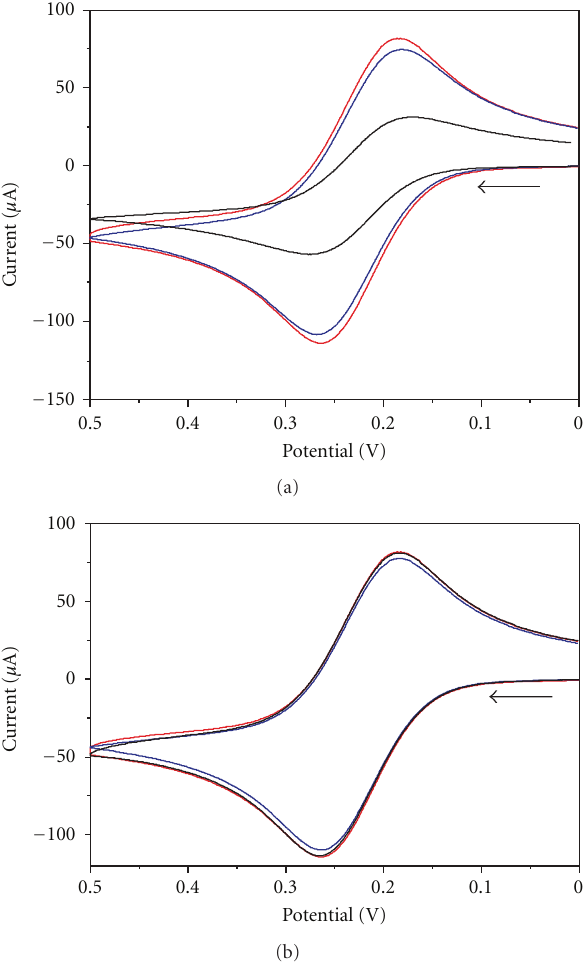
Figure 7: CVs of ferrocene methanol (1mM) in 0.1M KCl at 0.1V/s. (a) Red: bare gold, blue: silica film/sphere-coated electrode with many defects in the colloidal crystal, and black: silica film/sphere-coated electrode with fewer defects in the colloidal crystal. (b) Red: bare gold , blue: after sphere removal via soaking in chloroform for 3 hrs, and black: after particle growth for 45